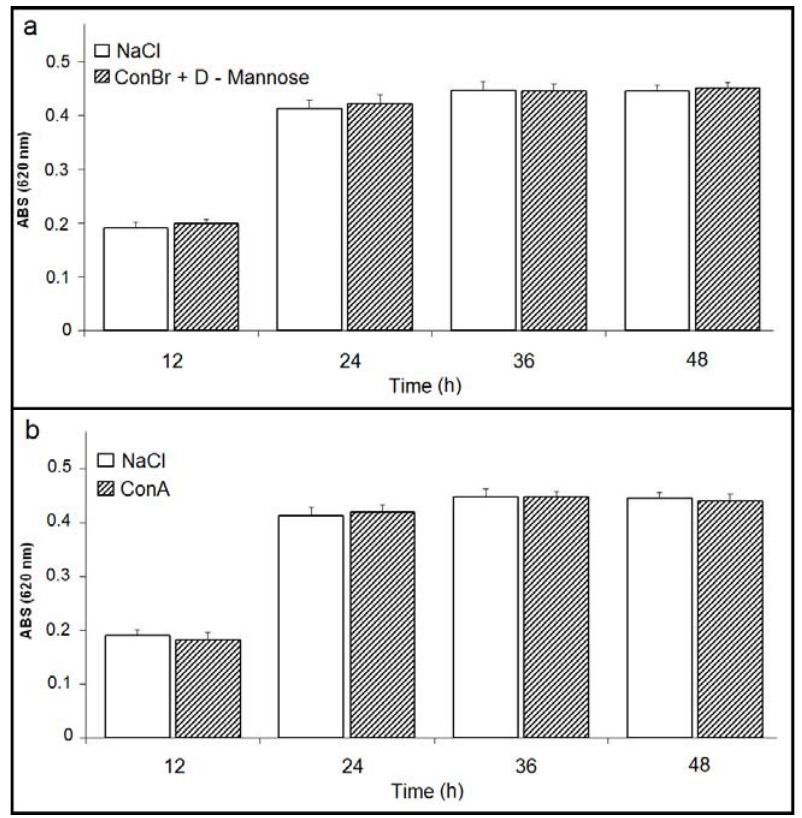
Figure 3. ( a ) Effect of ConBr complexed with D -mannose on the growth of R. tropici ; ( b ) Effect of ConA on the growth of R. tropici